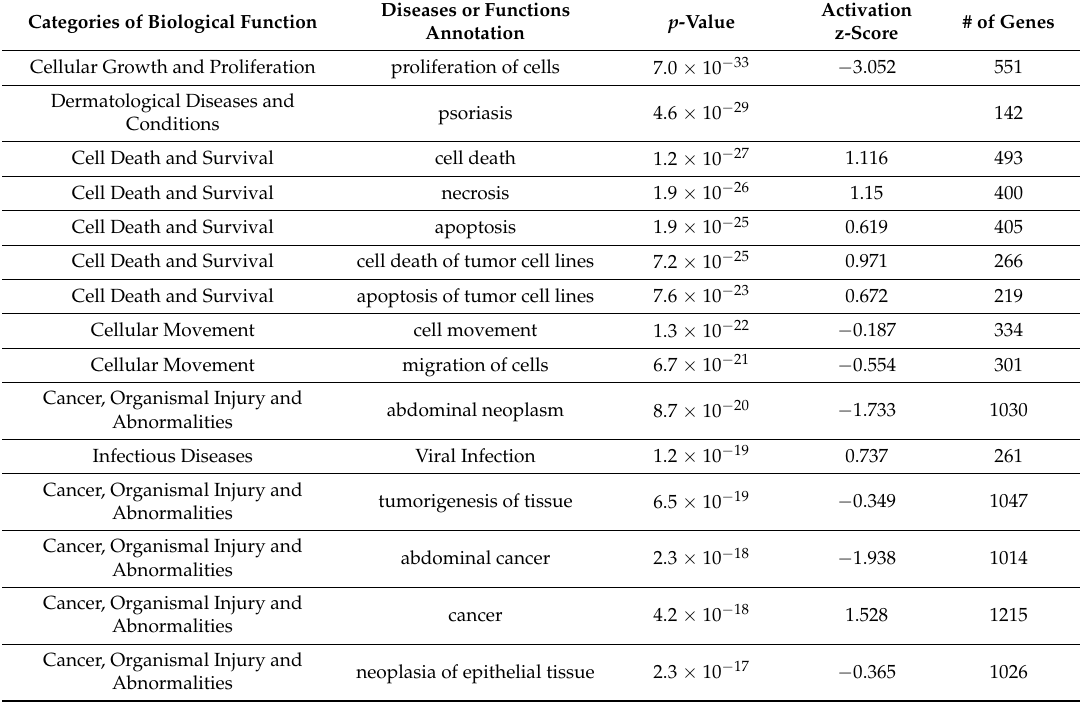
Table 13. Categories of biological functions with diseases or function annotation activated by 20,23(OH) 2 D3 in human epidermal keratinocytes after 24 h of